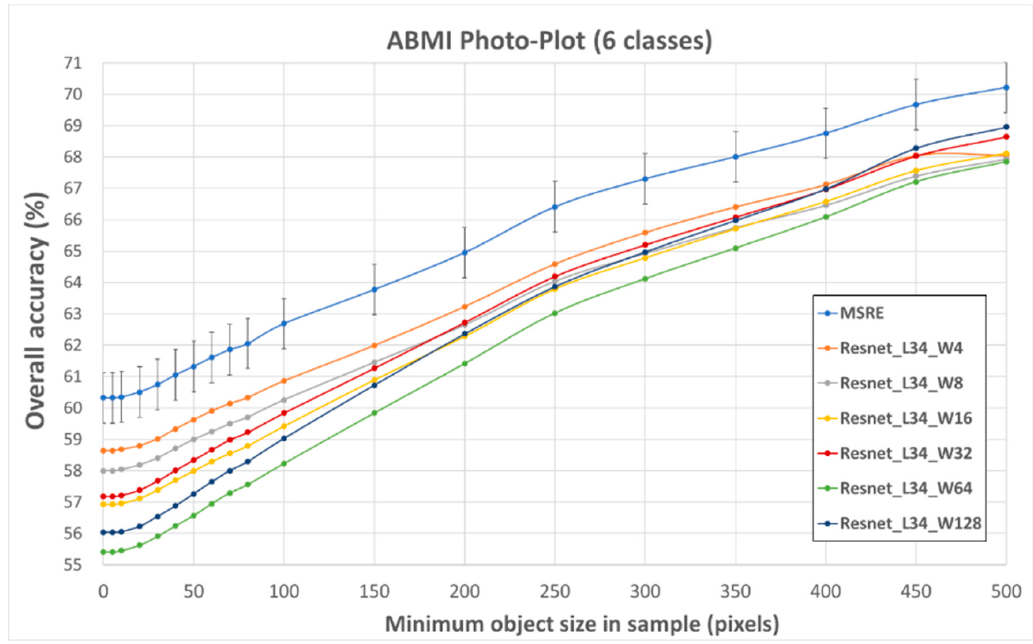
Figure 5. Overall accuracy for ABMI_PP with minimum object size in the test sample for the six CWCS classes based on the spatial extension assessment and best-test training convergence.